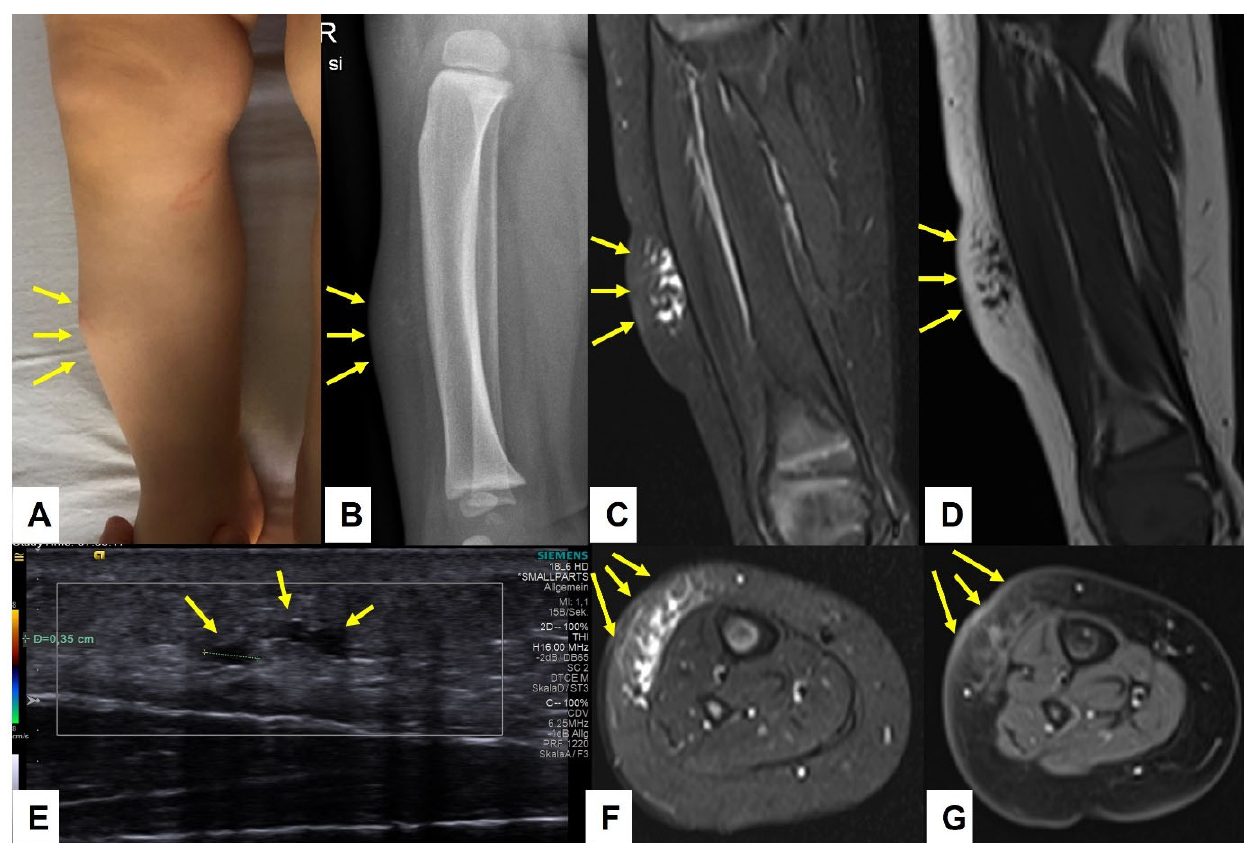
Figure 7. This composite figure illustrates a subcutaneous lump on the right lower leg of a 12-month- old girl ( A )—(arrows). X-ray at presentation showed a cloudy pretibial soft-tissue lesion with no osseous deformities ( B )—(arrows). Ultrasound imaging of the lesion was unspecific but showed some small cystic areas in the deep dermis ( E )—(arrows). MR imaging at the age of 13 months showed a strict epifascial tubulo-cystic lesion in the subcutaneous tissue in the anterolateral area without contrast enhancement ( C , D , F , G )—(arrows).